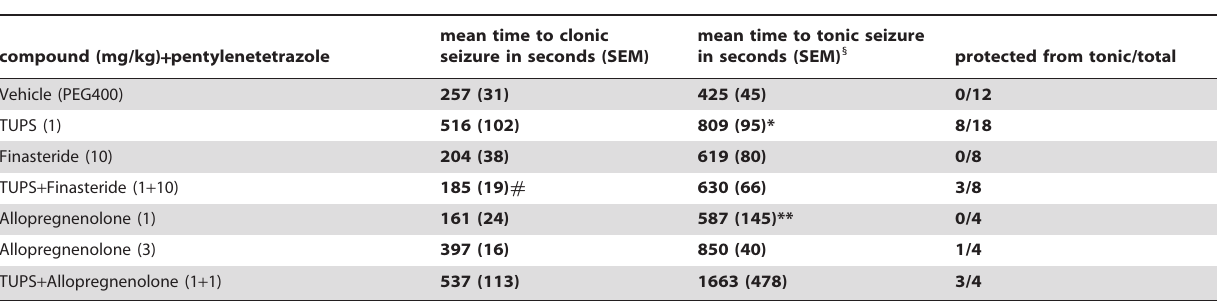
Table 2. The effects of allopregnenolone was significantly enhanced by sEHI and partially antagonized by finasteride (One Way ANOVA followed by Student Newman Keuls post hoc analysis TUPS + Allo vs TUPS, *p =0.016, TUPS + Allo vs Allo, **p= 0.007, TUPS vs TUPS + FIN, # p